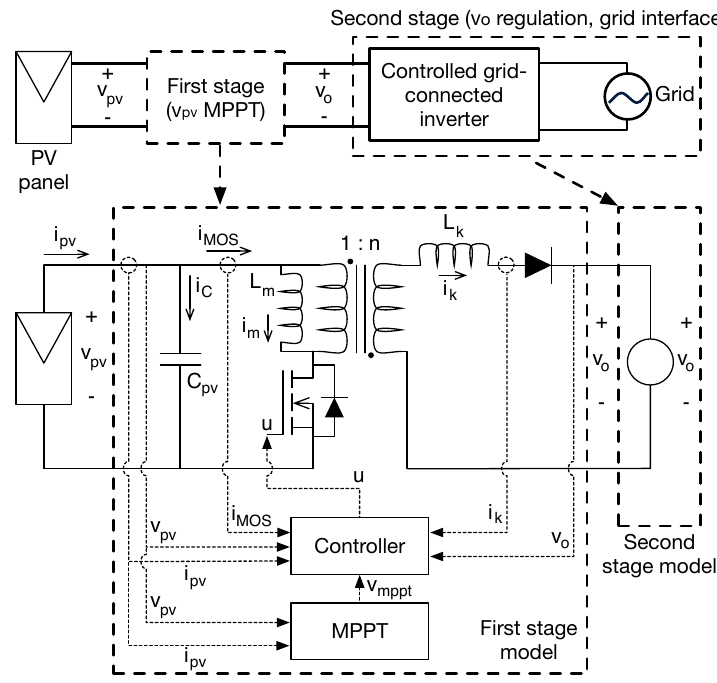
Figure 1. Electrical model of a flyback-based PV system as first the stage of a microinverter. The main perturbation sources affecting the PV microinverter